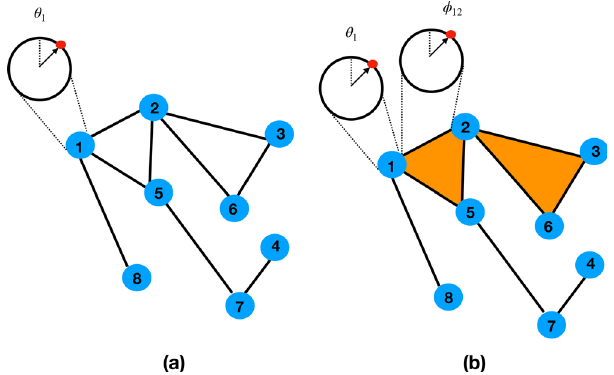
Fig. 1 Schematic representation of the Kuramoto and the higher-order topological synchronization model. Panel a shows a network formed by nodes and links in which nodes (blue circles numbered from 1 to 8) sustain a dynamical variable (a phase θ i with i ∈ {1, 2, … , 8}) whose synchronization is captured by the Kuramoto model. Panel b shows a simplicial complex formed by nodes, links, and triangles (here shaded in orange) in which not only nodes but also links sustain dynamical variables (indicated θ i for the nodes i ∈ {1, 2, … , 8} and ϕ ij for the links [ i , j ] with i , j ∈ {1, 2, … , 8}) whose coupled synchronization dynamics is captured by the higher-order topological Kuramoto